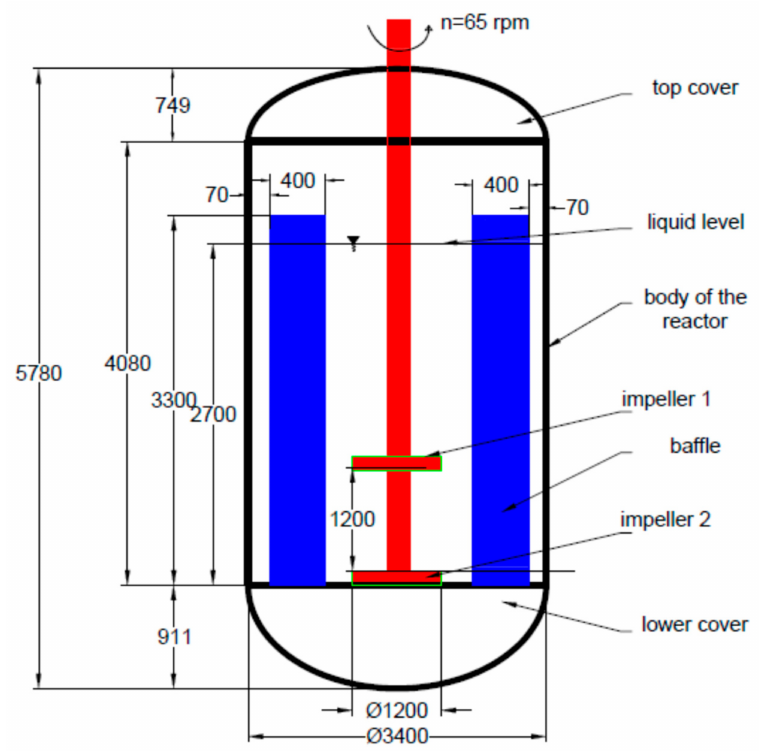
Figure 1. Schematic representation of the industrial reactor with original stirring mechanism fitted with the two new designed